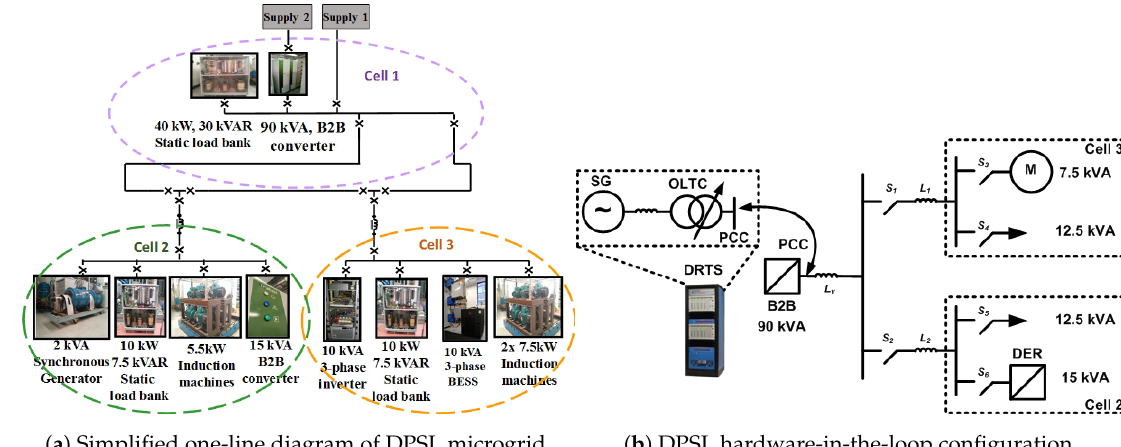
Figure 2. Test rig and hardware-in-the-loop